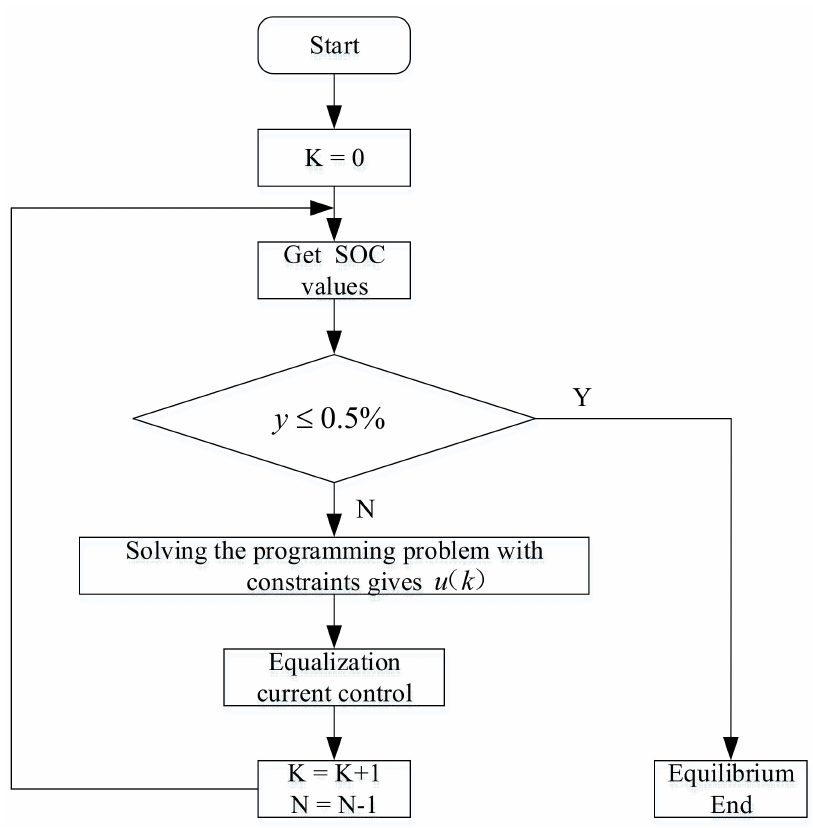
Figure 3. Flow chart of the balance control